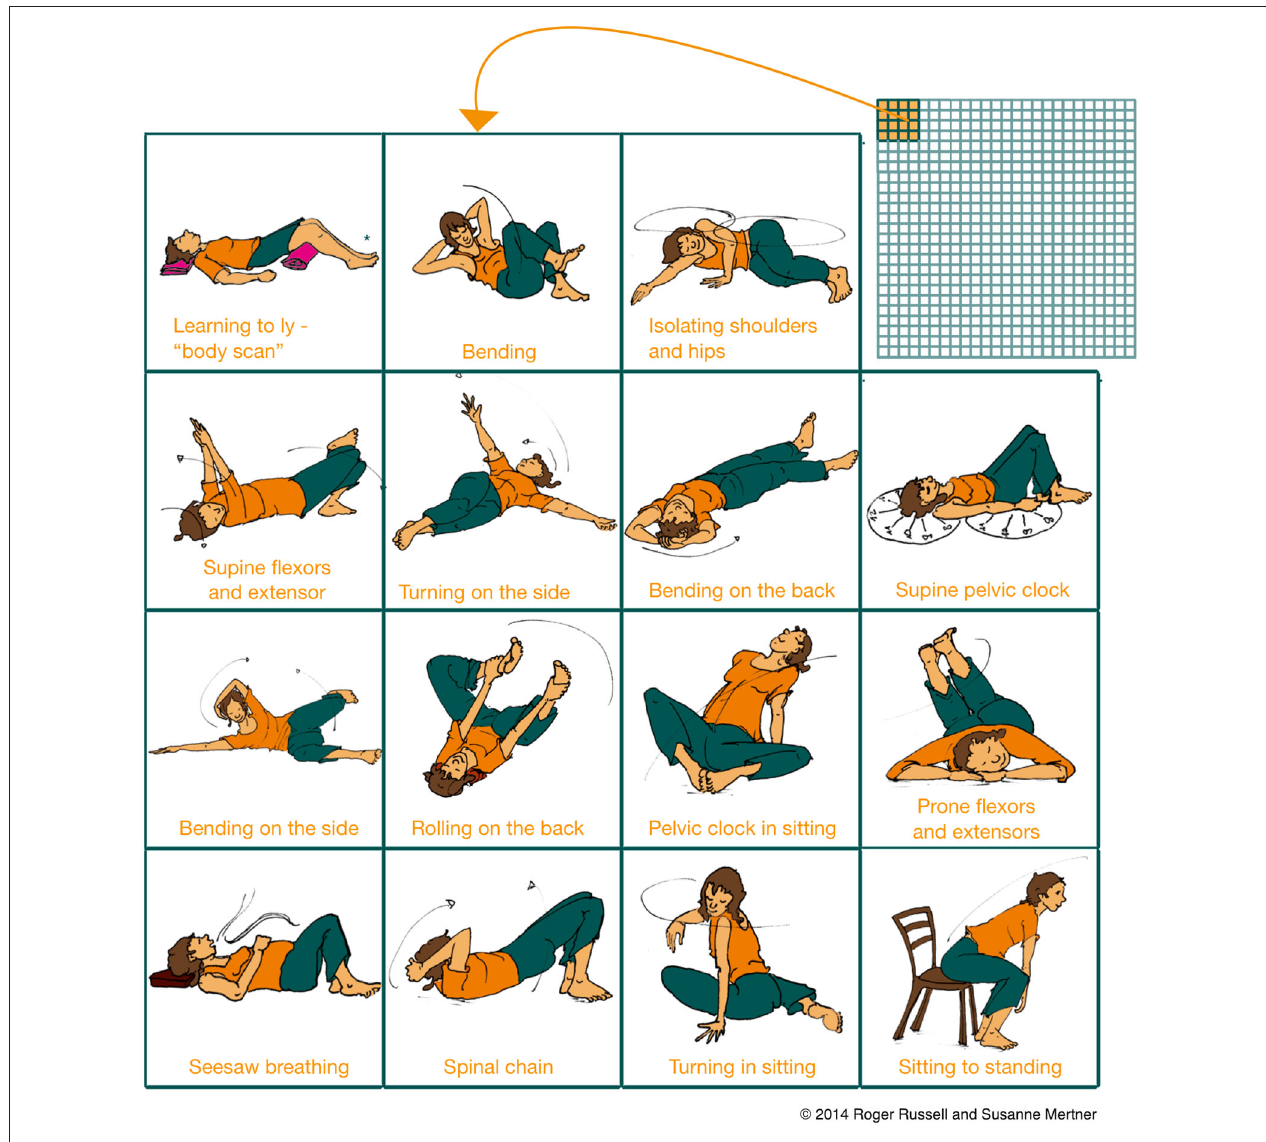
starting positions of the over 600 classical ATM lessons (matrix in the upper right corner) developed by Feldenkrais, exploring different movement themes over a broad variety of movement contexts. Similarly large numbers of structural movement variations are provided by traditional practices such as tai chi. Figure adapted with permission from Russell